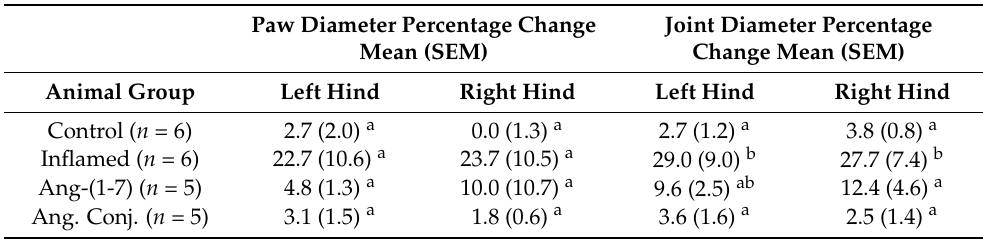
Table 1. The percentage change in paw and joint diameters in different treatment groups at the end of the experiment compared to day